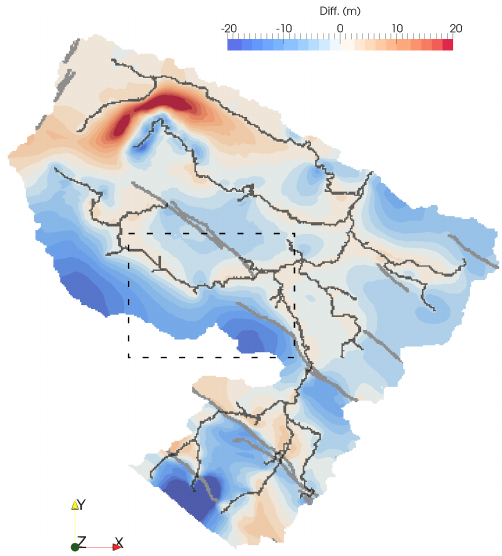
Figure 12. Absolute differences in depth from surface to groundwa- ter level between scenarios S1 and S2. Light gray lines show faults in the domain of S1; dark gray lines show rivers. The dashed rect- angle displays the frame for Fig.